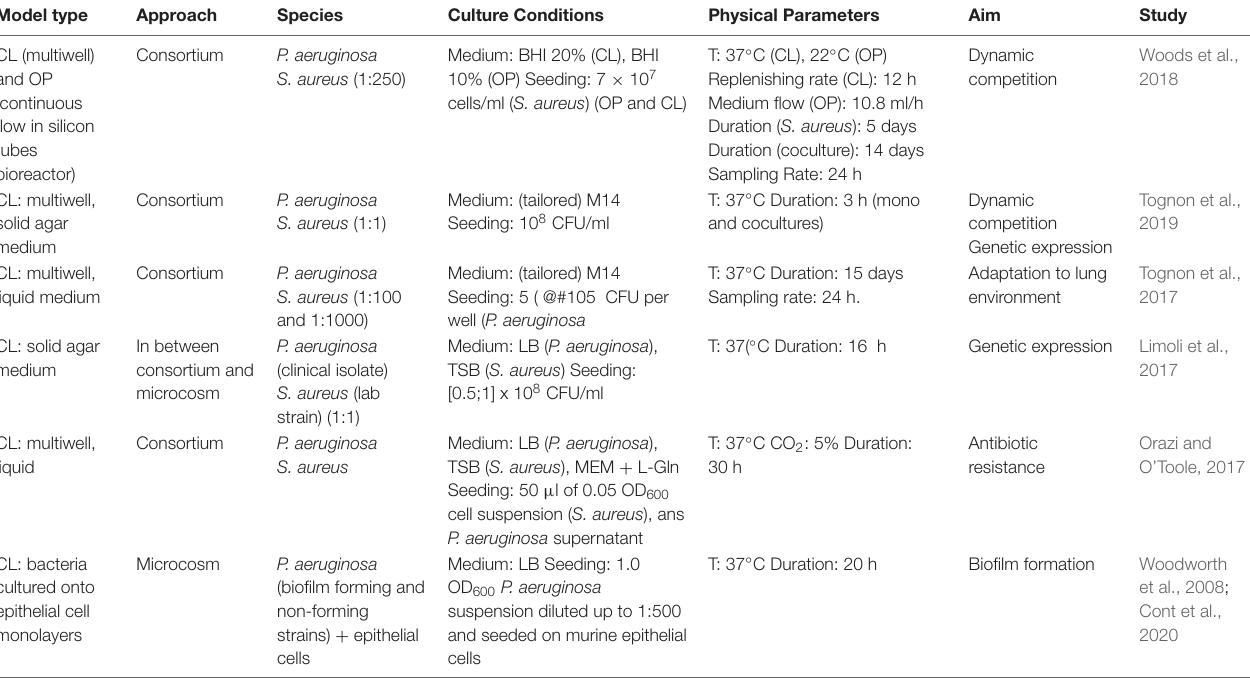
TABLE 4 | Main features of recent experiments designed to explore bacterium–bacterium interactions in the case of cystic fibrosis. Model